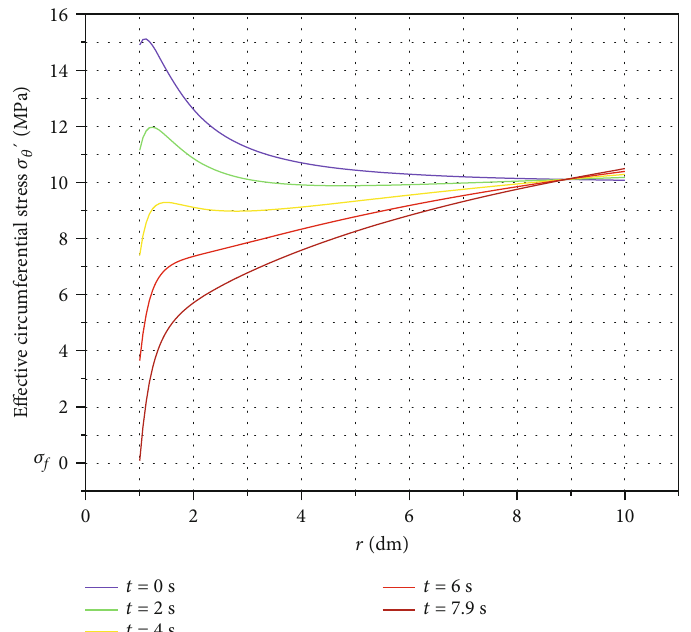
′ with radial distance for the case of wellbore fl uid fl owing into rock and accounting seepage force. Figure 8: The variation of σ θ